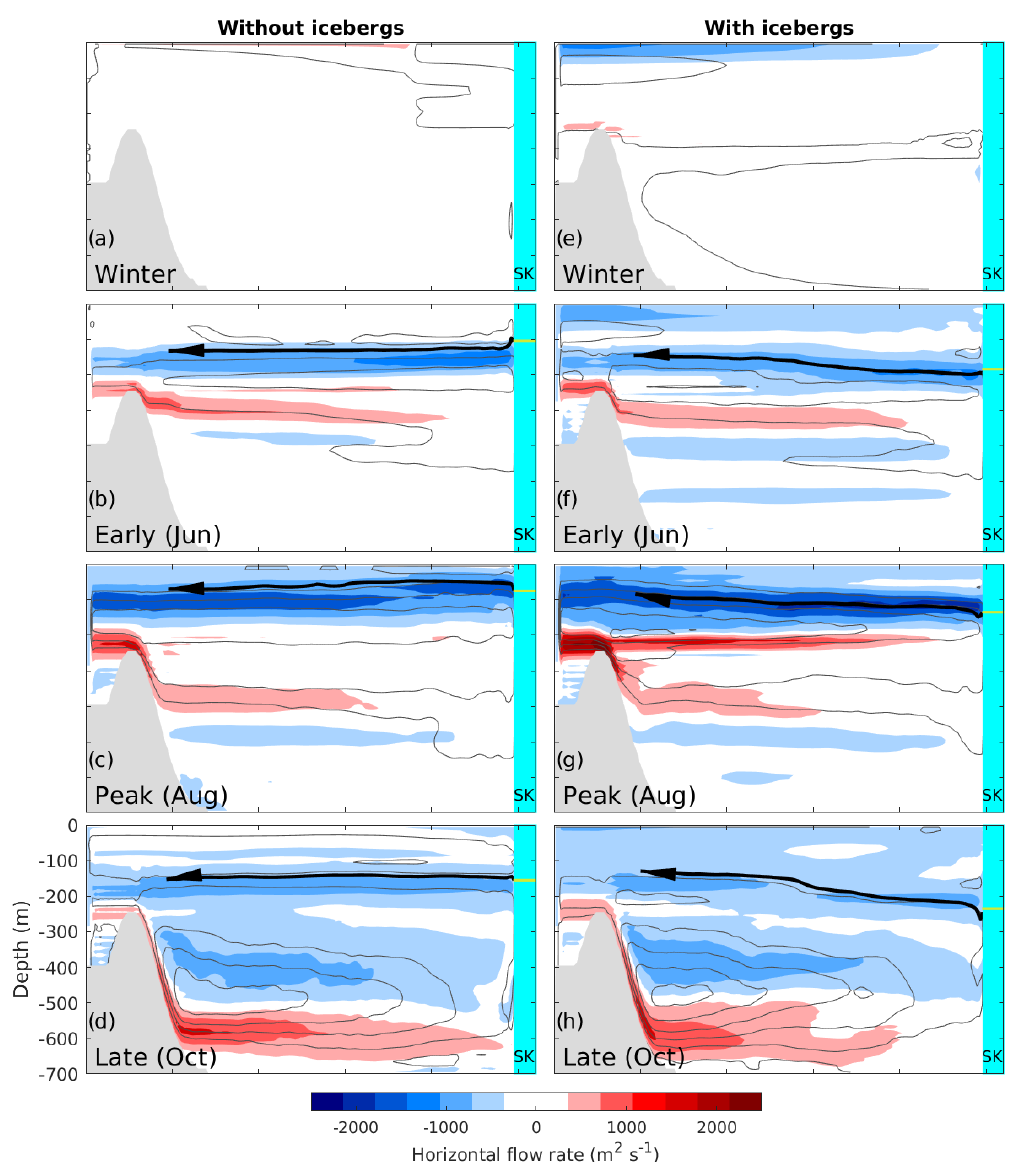
Figure 4. Snapshots of the horizontal flow rate along the fjord for the winter (March), early (June), peak (August) and late (October) season, without icebergs (NoIBP, a–d ) and including icebergs (IBP, e–h ). Black arrows indicate the centreline of the GMW outflow from the plume and grey contours streamlines of the horizontal flow rate at 0.02m 3 d − 1 intervals. The horizontal orange line marked on the pale blue glacier front indicates the neutral buoyancy depth of the